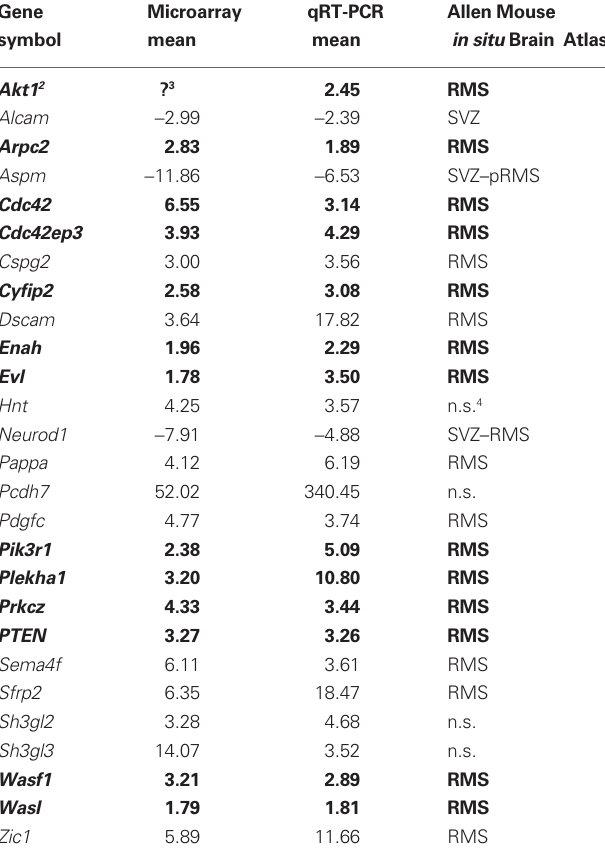
Table 2 | Comparison of aRMS-pRMS gene expression differences obtained by microarrays, qRT-PCR and Allen Brain Atlas in situ